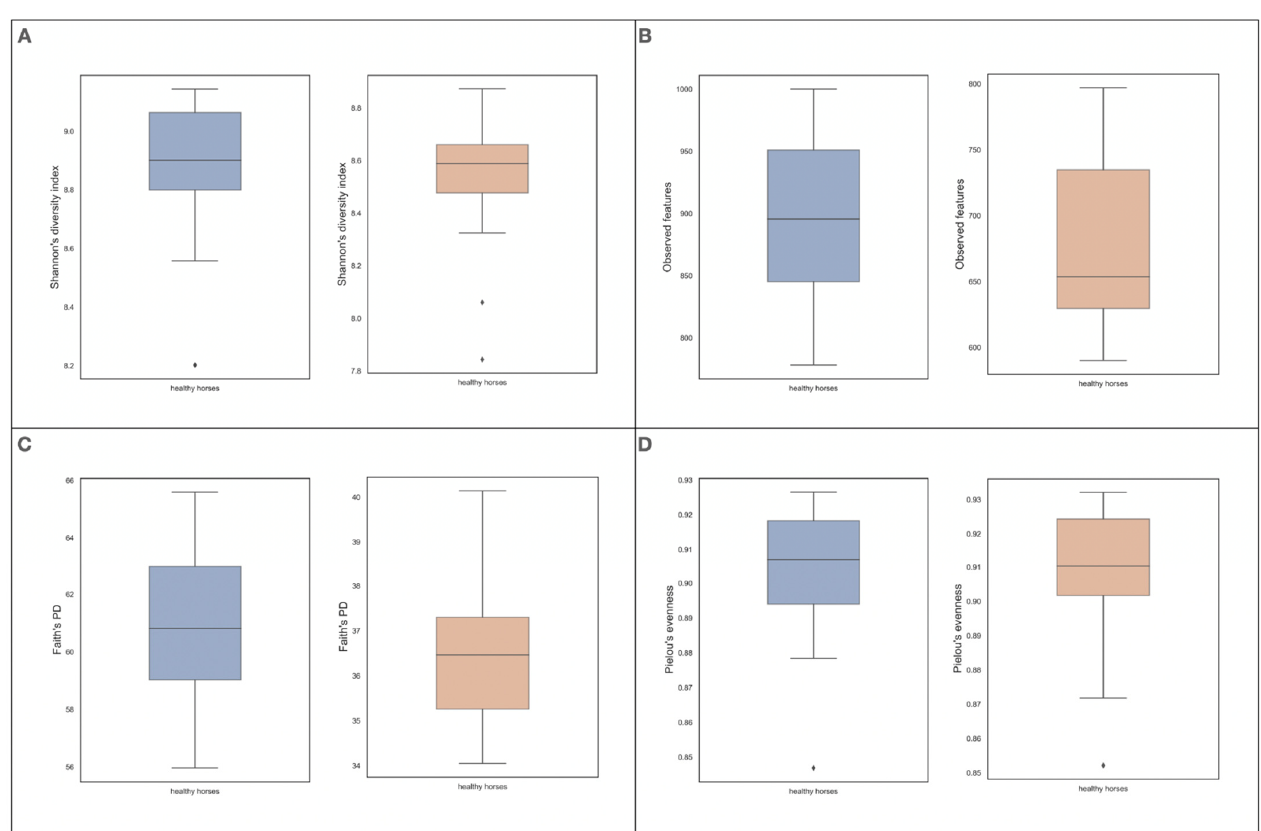
Figure 1. Alpha-diversity measures based on hypervariable regions of 16S rRNA gene, blue boxplot on the left side of each panel based on V3–V4 and orange boxplot on the right side based on V7–V9 hypervariable region, respectively. ( A ) Shannon’s diversity index: V3–V4 8.849 (0.276), 8.901 (0.265)